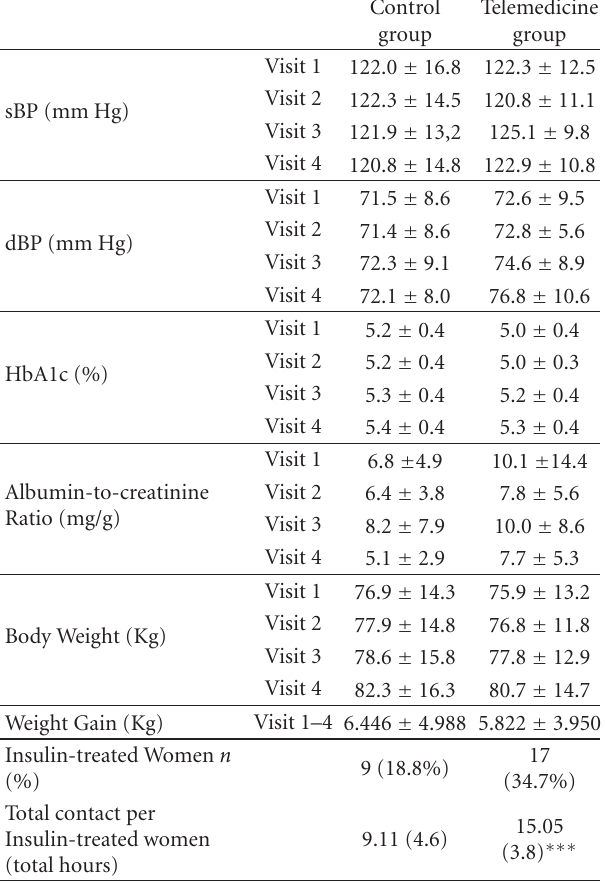
Table 2: Maternal Metabolic parameters during